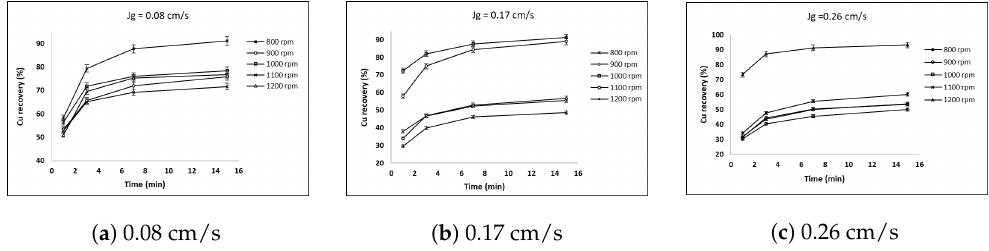
Figure 11. Copper recovery vs. time at different Jg values ( a ) 0.08 cm/s, ( b ) 0.17 cm/s and ( c ) 0.26 cm/s) using an impeller of a diameter of 6 cm.